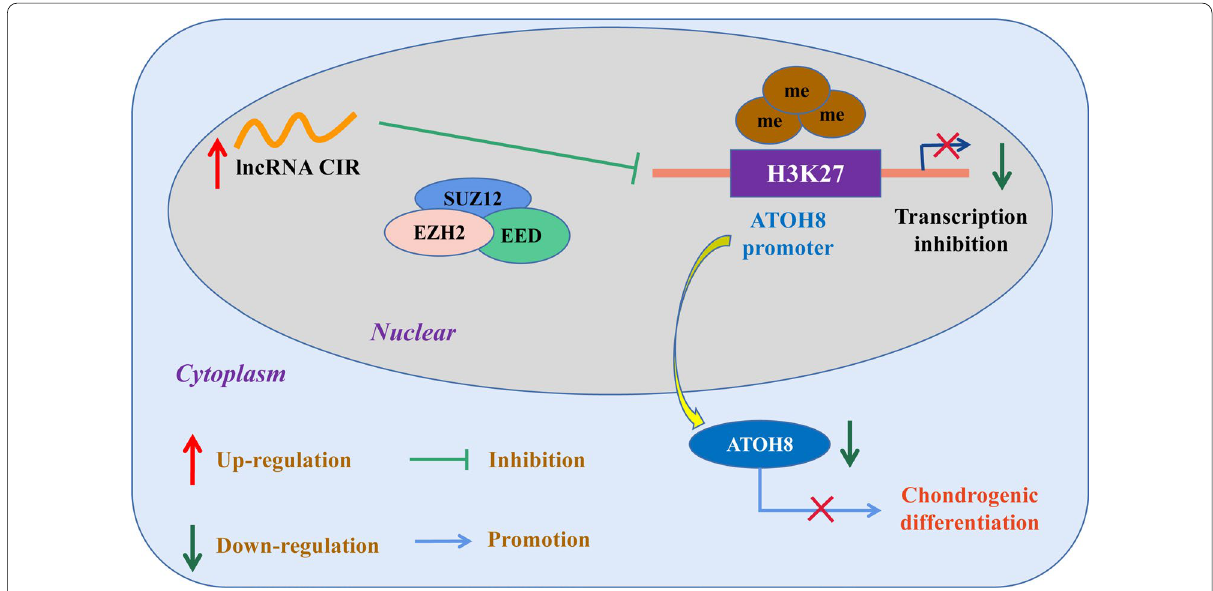
Fig. 7 Schematic diagram demonstrates the role of lncRNA CIR/EZH2/ATOH8 axis in chondrogenic